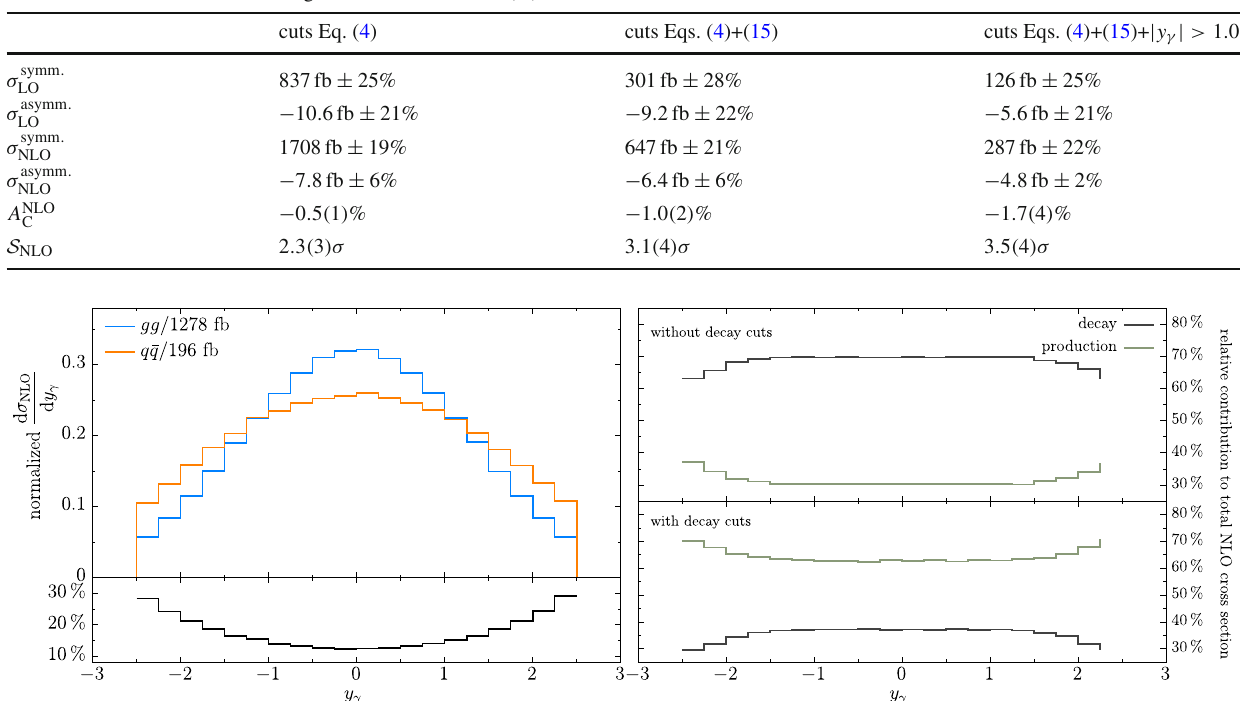
Fig. 1 Left: Normalized photon rapidity distribution of the gg and q ¯ q initial states (upper pane) and relative contribution of the q ¯ q initial state with respect to the total contribution (lower pane). Right: Relative contribution of photon radiation in production and photon radiation in